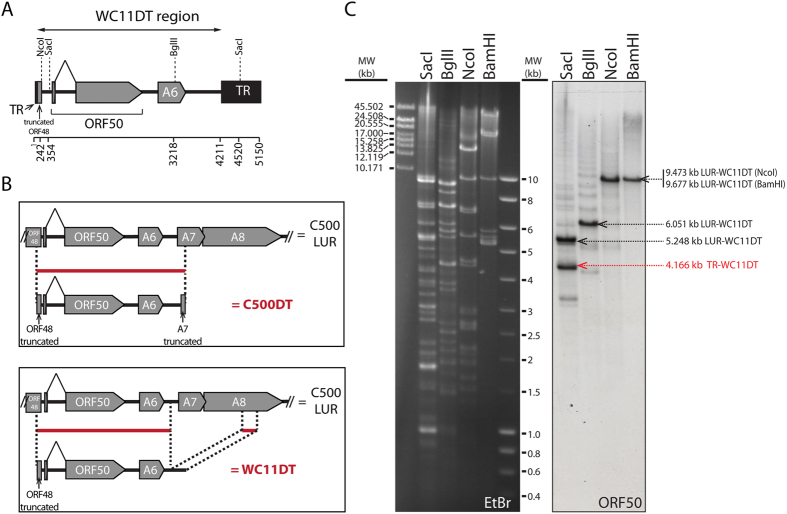
ORF50 and A6 are duplicated in strain WC11.(A) Diagram of the duplicated region (WC11DT) containing ORF50 and A6 identified by sequencing. (B) Diagrams of the aligned C500DT and WC11DT sequences on the C500 LUR sequence. Red lines correspond to the duplicated regions from LUR. (C) Localization of the duplicated region by endonuclease restriction and Southern blotting. The ORF50 probe was produced by PCR using primers C500-1 and C500-224. Red font indicates the duplicated fragment containing ORF50. Black font indicates the fragment containing ORF50 in LUR. EtBr indicates ethidium bromide-stained lanes prior to blotting. Entire gels and blots are shown with ladders of medium (MW) and high molecular weight (High MW) standards.